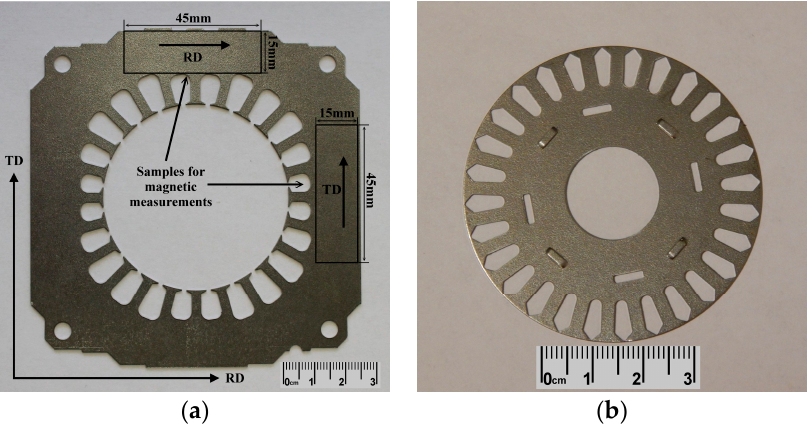
Figure 2. Experimental samples in form of stator ( a ) and rotor ( b ) segments of electric motor.